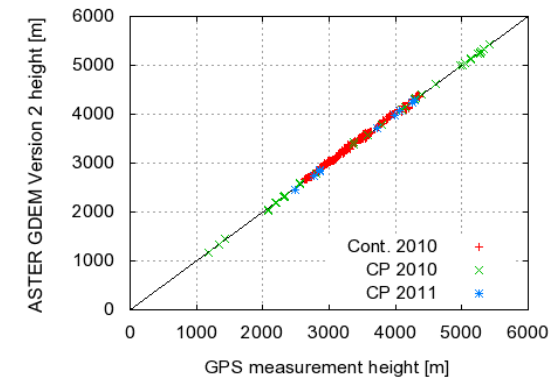
Figure 10. Histogram of height differences between ASTER GDEM-2 and ground-based GPS